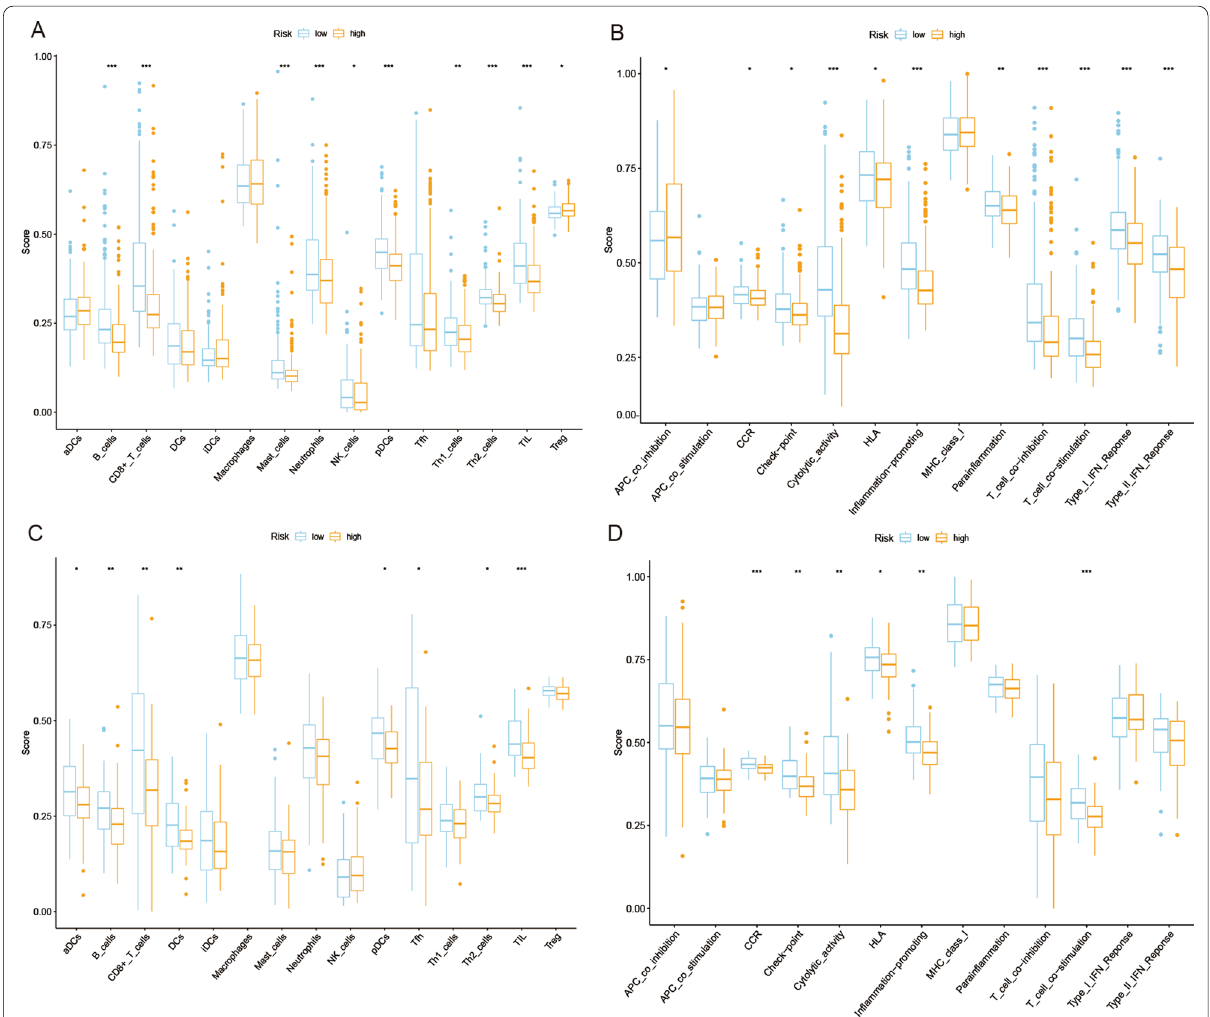
Fig. 7 Comparison of the ssGSEA scores for immune cells and immune pathways. A , B Comparison of the enrichment scores of 15 types of immune cells and 13 immune-related pathways between the low- (blue box) and high-risk (orange box) groups in the TCGA cohort. C , D Comparison of tumor immunity between the low- (blue box) and high-risk (orange box) groups in the GEO cohort (*p < 0.05; **p < 0.01; ***p <